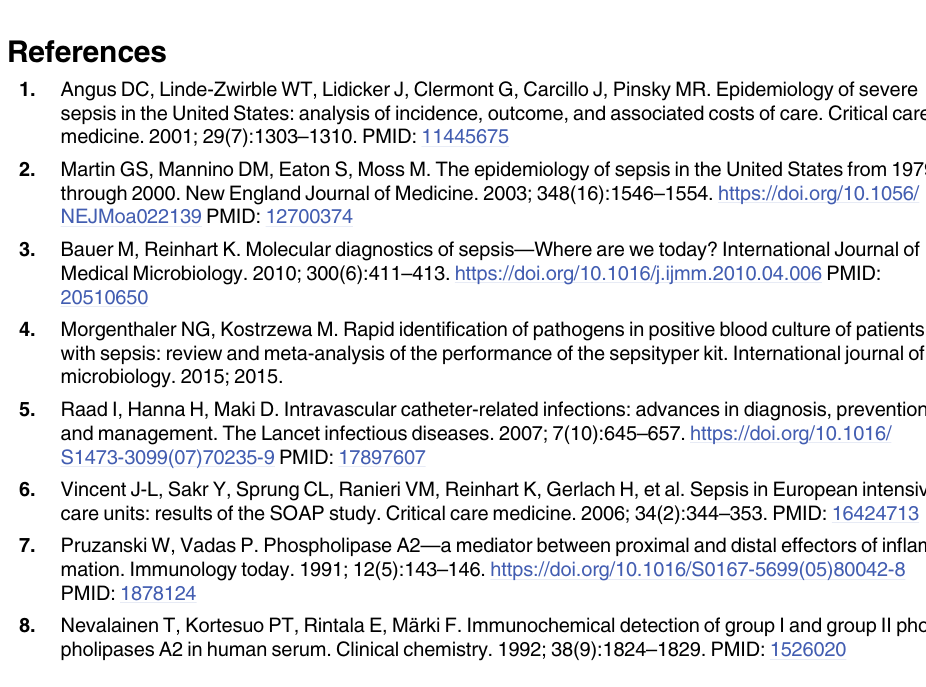
S2 Table. List of full-text excluded articles. (DOCX) S3 Table. PRISMA